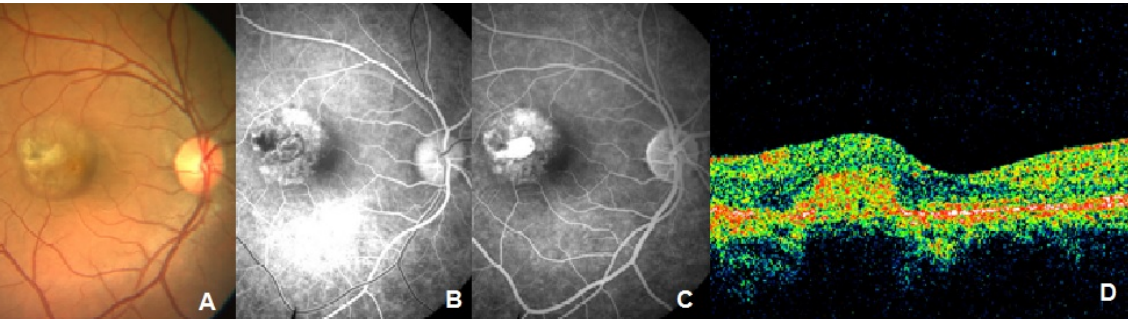
Figure 3: FFA and OCT findings after 4 th Injection of bevacizumab. FFA shows late leakage, no subretinal fluid detected on OCT.